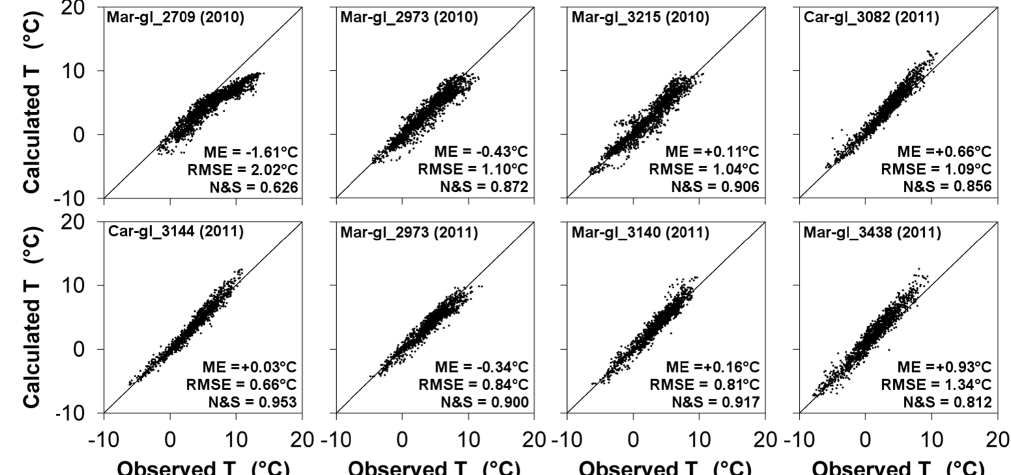
Figure 7. On-glacier temperature calculated with the Shea and Moore (2010) method vs. observed temperature.